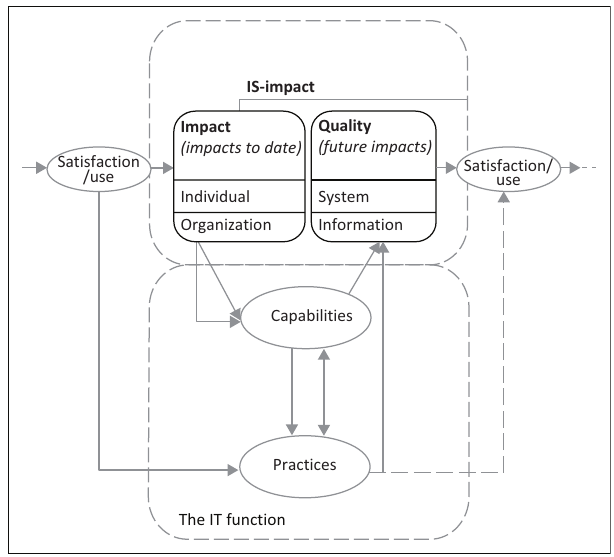
FIGURE 1: The information system impact measurement